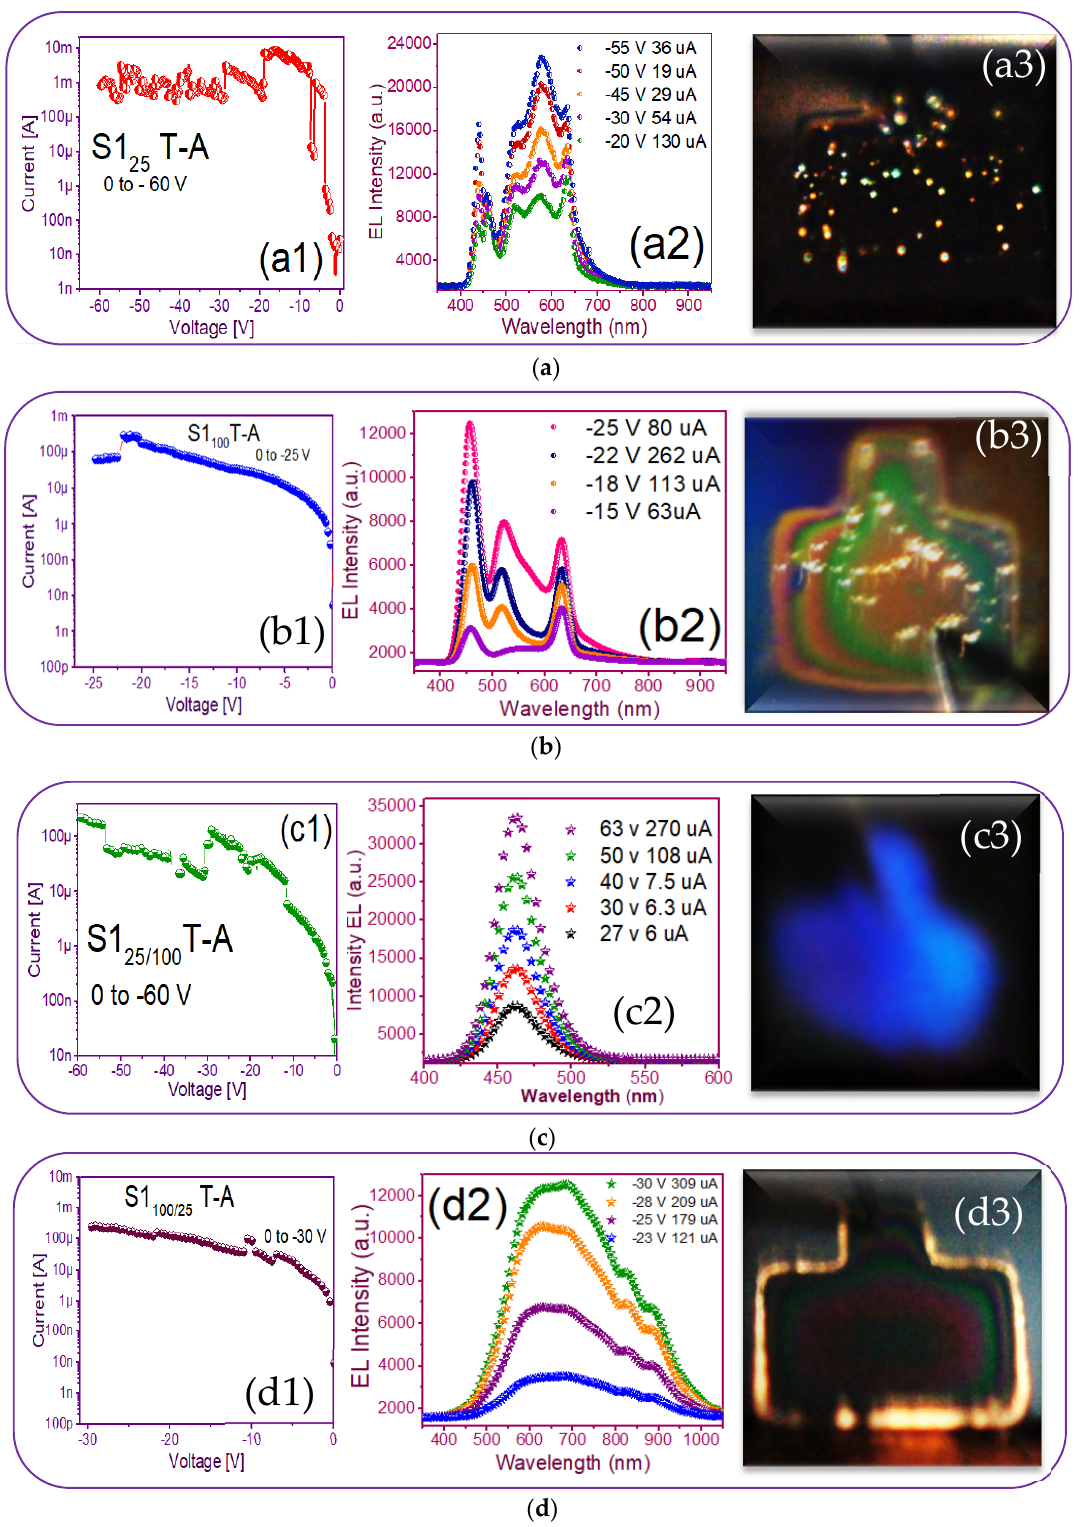
Figure 9. Current-voltage (I-V) and electroluminescence (EL) intensity curves and luminescent images of the ( a ) S1 25 T-A